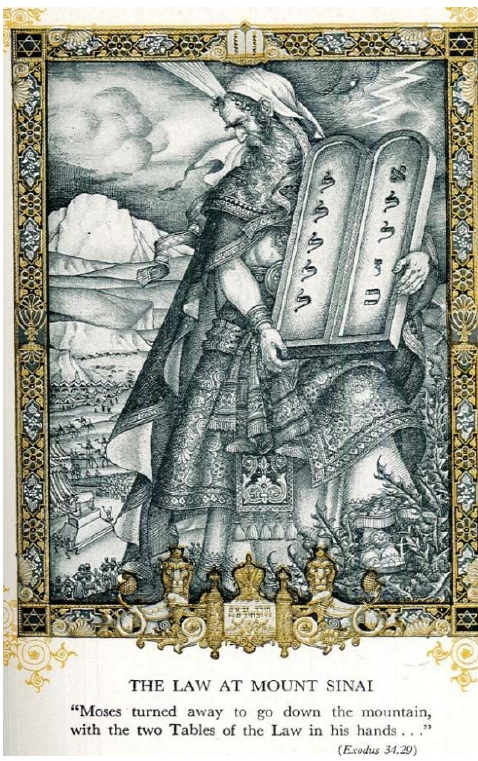
Figure 13. Moses, Pathways Through the Bible (Cohen 1946, facing p. 100).